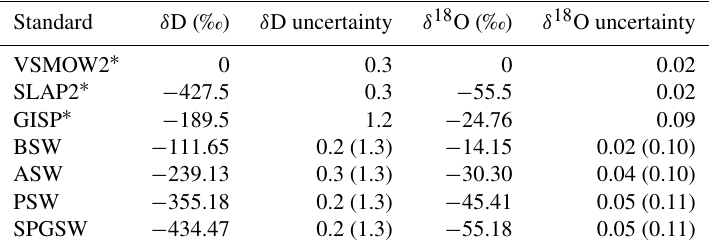
Figure 4. System diagram of the inlet system that introduces water vapor from a suite of isotope standards or from glass flasks in the nose cone sample pods. Table 1. Tracing of uncertainties is provided for primary reference water standards ( ∗ ) and secondary water standards developed in the laboratory, which are reported in units of per mil. The four secondary standards (BSW, ASW, PSW, and SPGSW) are previously calibrated in the laboratory and are defined relative to the primary standards (VSMOW2, SLAP2, and GISP) on which values and uncertainty are reported by the IAEA. Secondary standards are reported with uncertainty determined across multiple IRMS and CRDS platforms. In parentheses is the combined uncertainty of both the primary and secondary standard tie, added in quadrature. Additional details describing the calibration scheme can be found in Jones et al. (2017b). Standard δ D